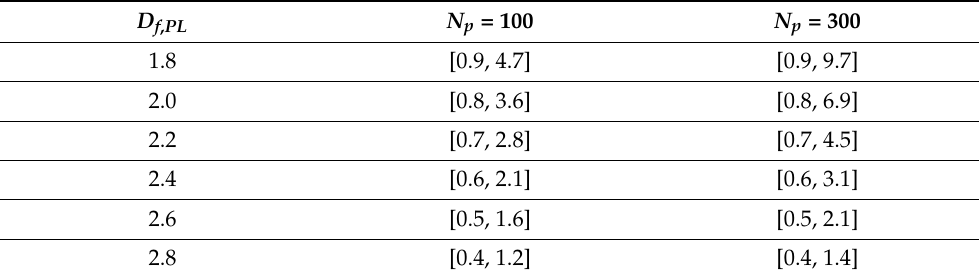
Table 2. Lower and upper limits of the effective range of k PL for different D f , PL and N p .